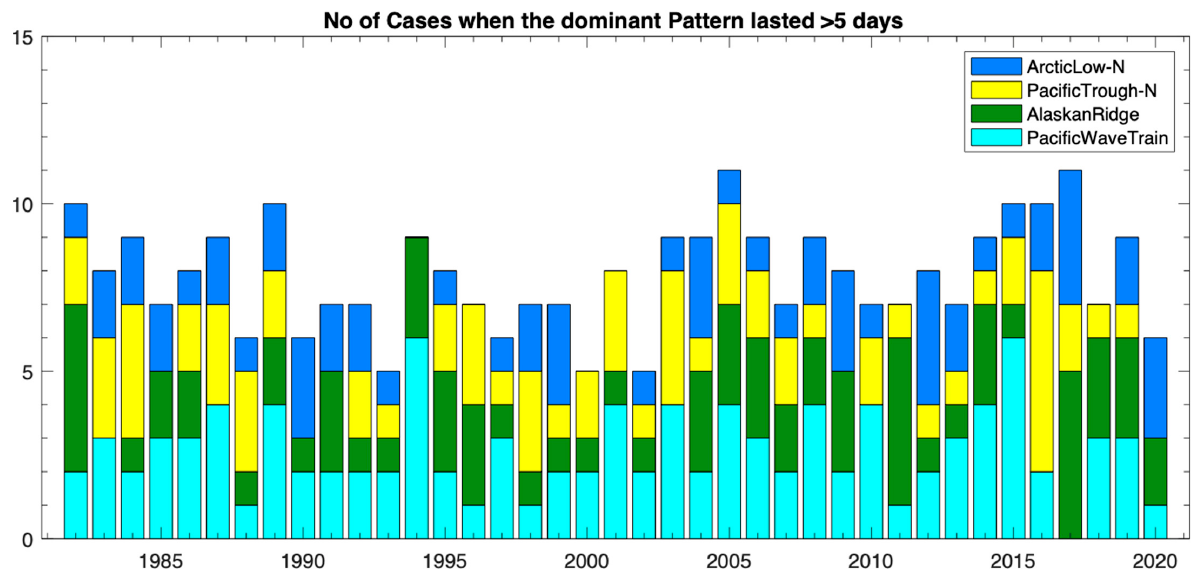
Figure 5. A histogram of the number of events that last longer than 5 days in a given year for each